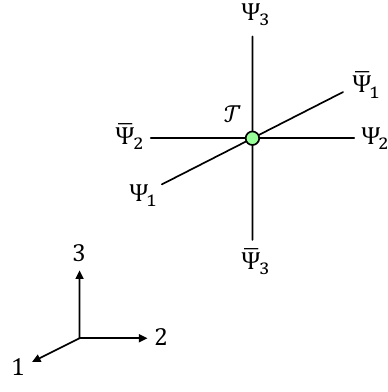
Figure 3 . Graphical representation of eq. (3.10) in three